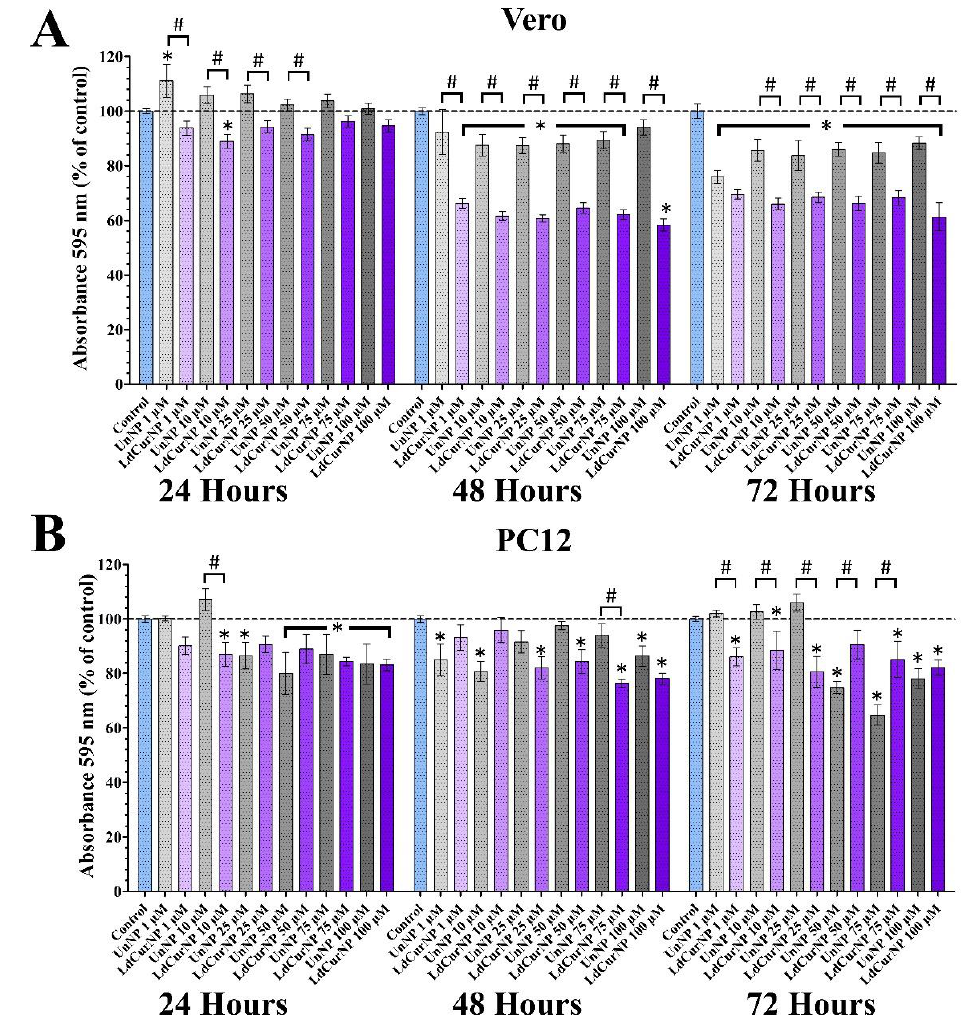
Figure 6. MTT assays of Vero and differentiated PC12 cells after 24, 48 and 72 h of incubation with the nanoparticles’ suspensions in different concentrations. Absorbance was determined in spectrophotometer at wavelength of 595 nm and values are presented as mean ± standard error of the % of control group (* and # p < 0.05; n.s. p > 0.05). ( A ) Vero cells treated with L-DOPA and Curcumin-loaded nanoparticles (LdCurNP) and unloaded nanoparticles (UnNP) suspensions in concentration of 1, 10, 25, 50, 75 and 100 µ M. ( B ) differentiated PC12 cells treated with LdCurNP and UnNP suspensions in concentration of 1, 10, 25, 50, 75 and 100 µ